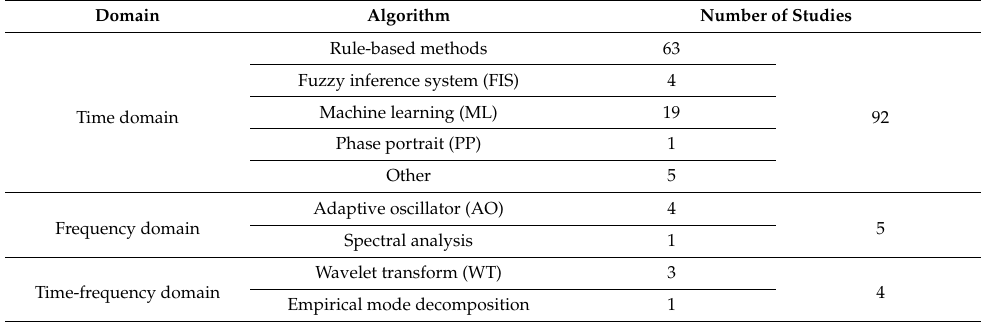
Table 4. Classification of studies based on the type of gait analysis methods used; the number of studies which followed a type of method is listed in the table. Note that a few studies were counted in more than one category when those studies involved more than one